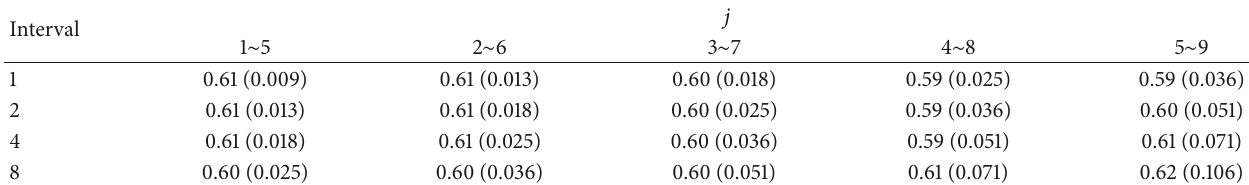
Table 2: Simulation data analysis for H ( H = 0.6, data length = 180000).